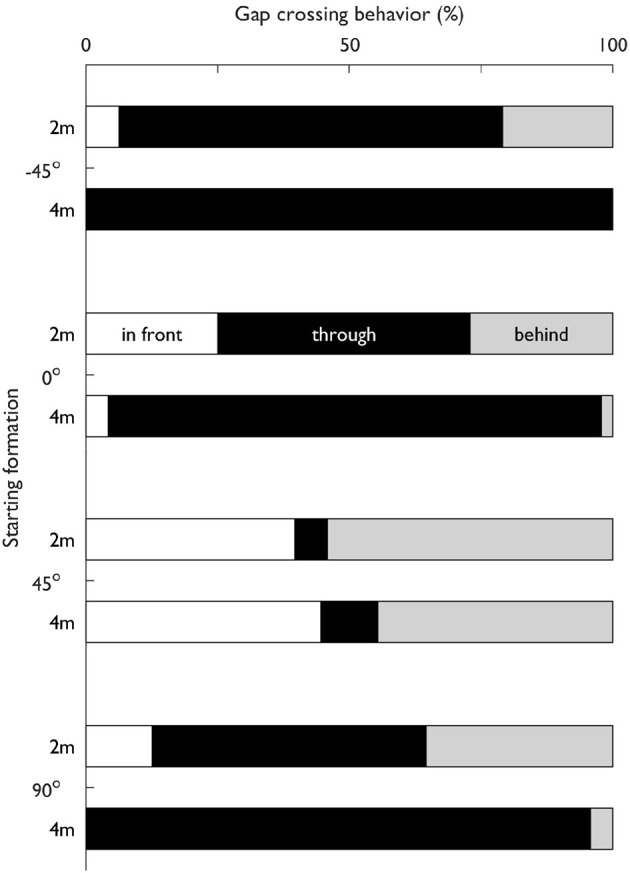
Gap crossing behavior (i.e., in front, through or behind) of Walker 1 (W1) relative to the other walkers in the triadic trials as a percentage per starting formation.